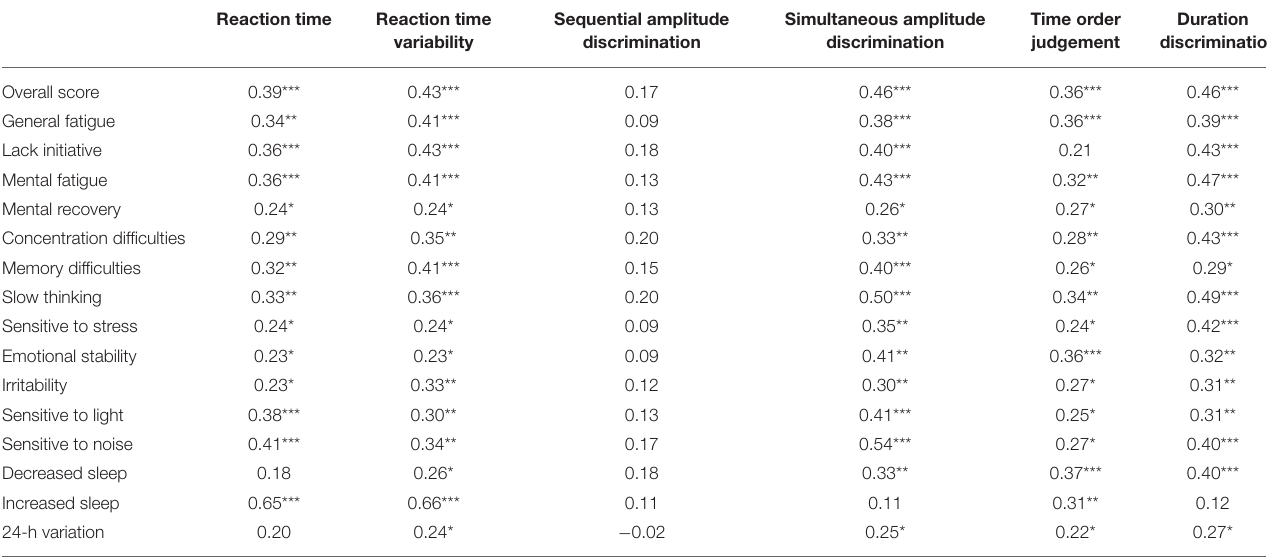
Reaction time Reaction time Sequential amplitude Simultaneous amplitude Time order Duration variability discrimination discrimination judgement discrimination